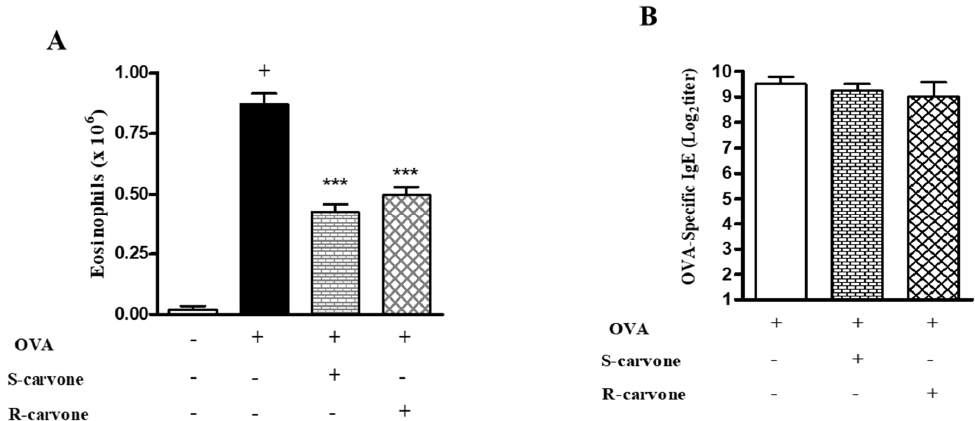
Figure 6. E ff ects of the treatment with carvone enantiomers on allergic sensitization. BALB / c mice were orally pre-treated with R-carvone (10 mg / Kg) or S-carvone (10 mg / Kg) 1 h before each sensitization. ( A ) Eosinophils per BAL counted under light microscopy and ( B ) Titers of OVA-specific IgE in the serum were assessed using the PCA test 24 h after the last OVA-challenge. Results are expressed as means ± SEM and are representative of two independent experiments performed with 6–8 animals per group. + significant di ff erence ( p < 0.05) from the unchallenged group; *** significant di ff erence ( p < 0.001) from the untreated OVA-challenged group. Statistical significance was determined with one-way ANOVA and post hoc Tukey test.